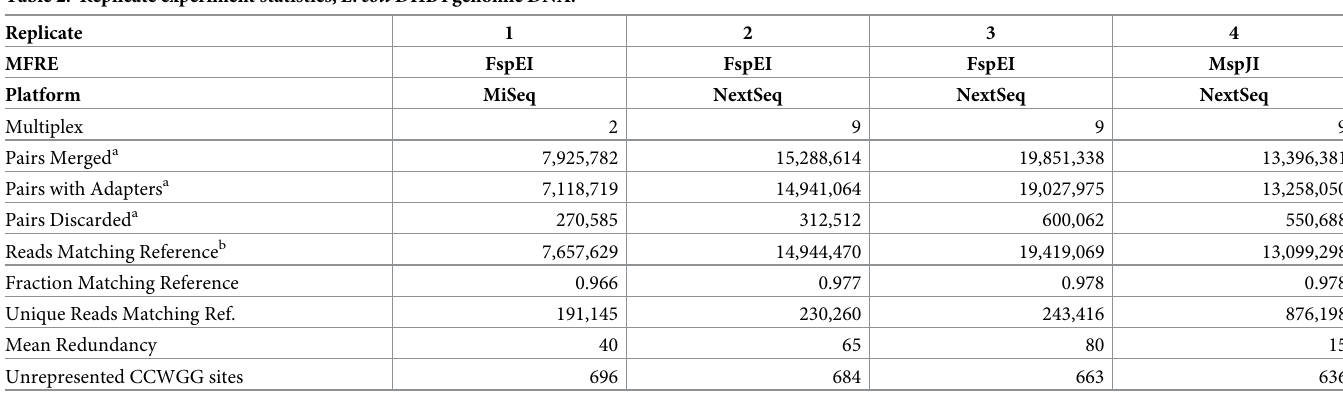
Table 2. Replicate experiment statistics, E . coli DHB4 genomic DNA.